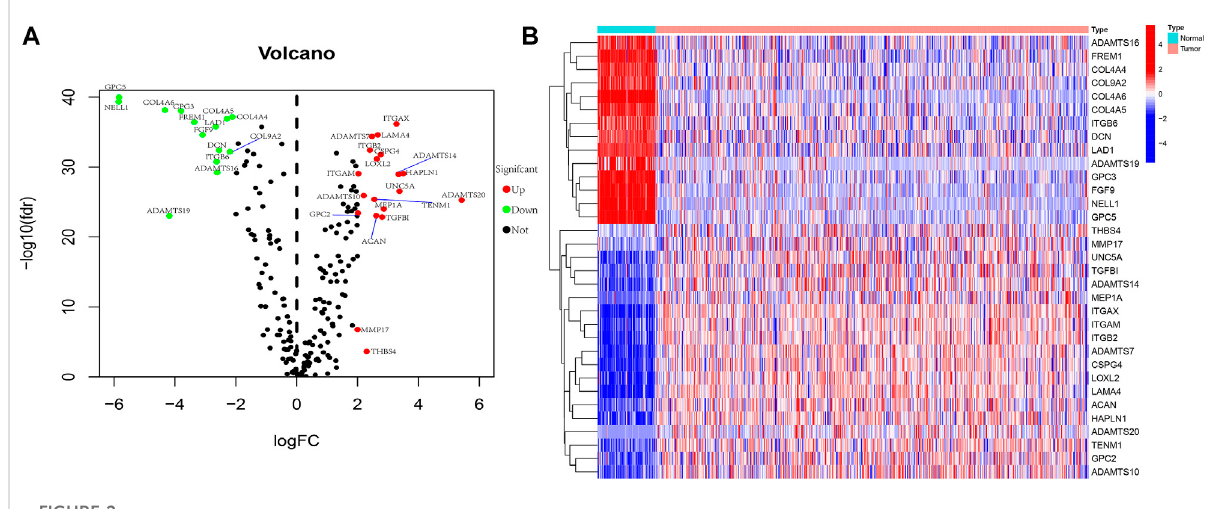
FIGURE 2 Exhibition of 33 differentially expressed BMRGs. (A) Volcano plot. (B)